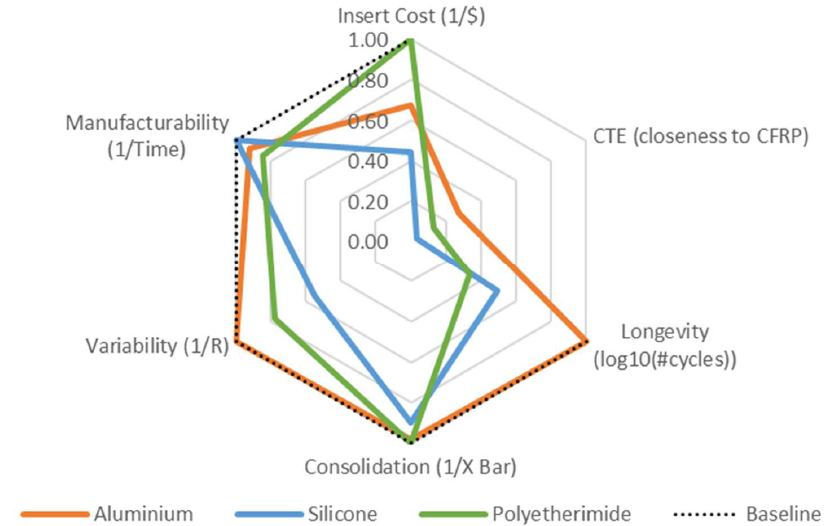
Figure 13. Radar chart with normalized values representing suitability to key design requirements for all samples.